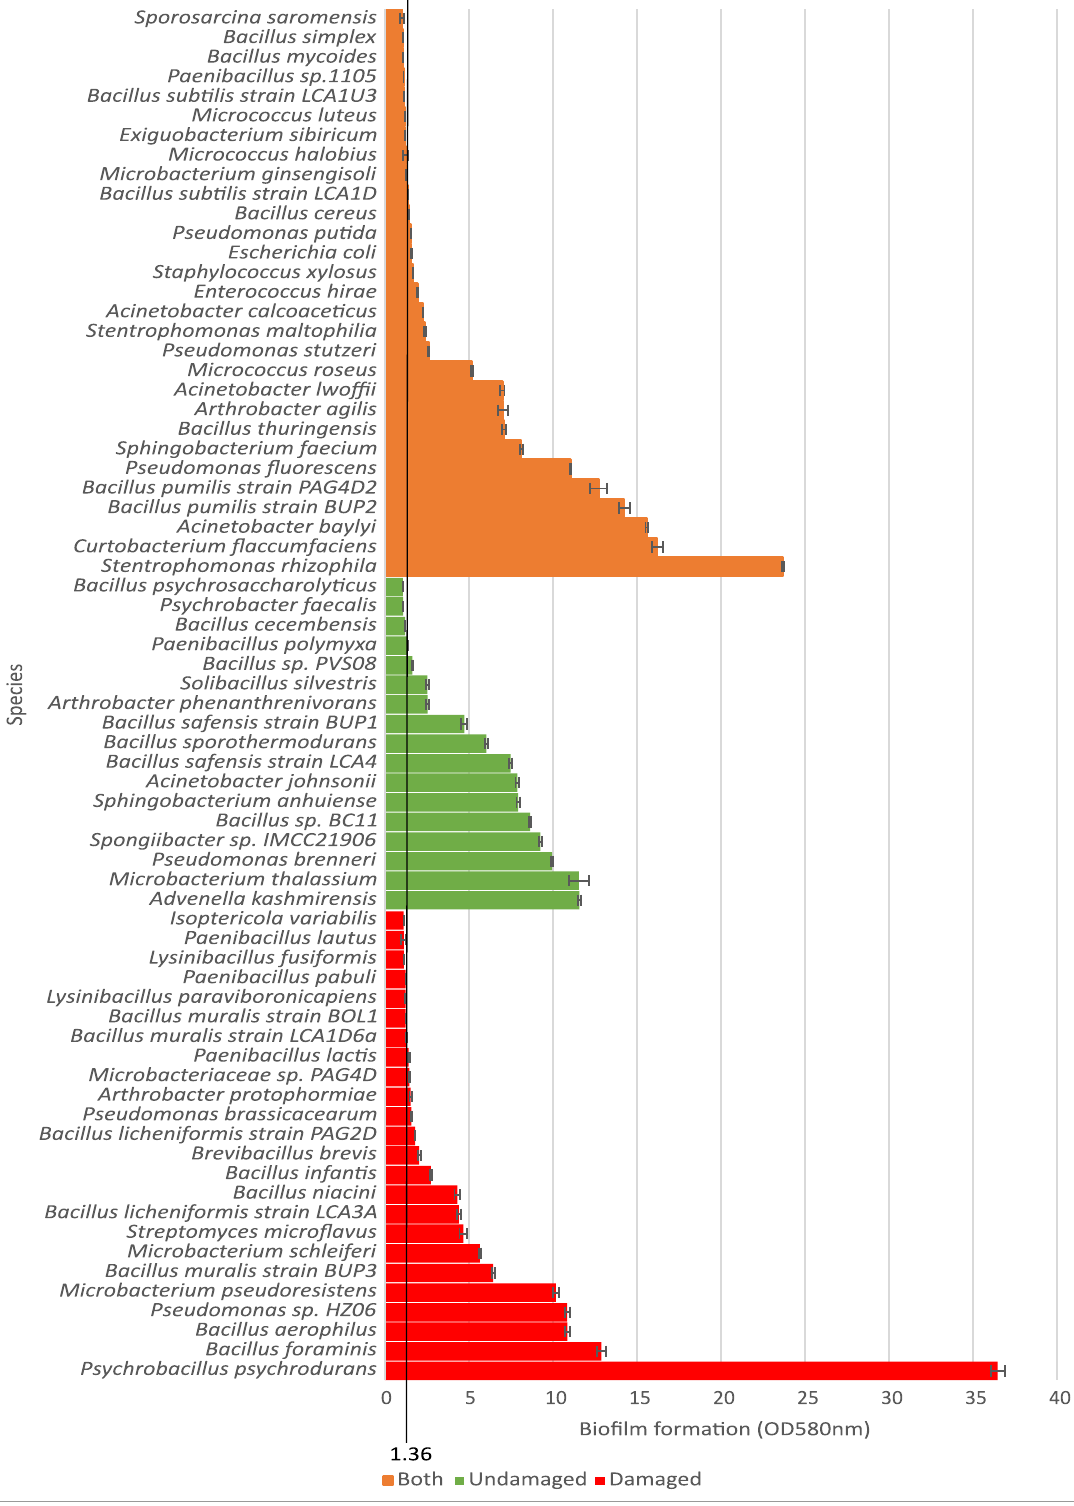
Figure 3. Biofilm formation capacity as a ratio of the OD580nm readings of the biofilm coated peg and the negative control peg. Data shown is average of n = 3. Species below 1.36 are poor or non-biofilm formers. A positive skew towards high biofilm formers is present in the isolates from damaged surfaces (red) as well as those isolates from both surfaces (orange). Isolates from the undamaged surface (green) demonstrate a normal distribution in their ability to form